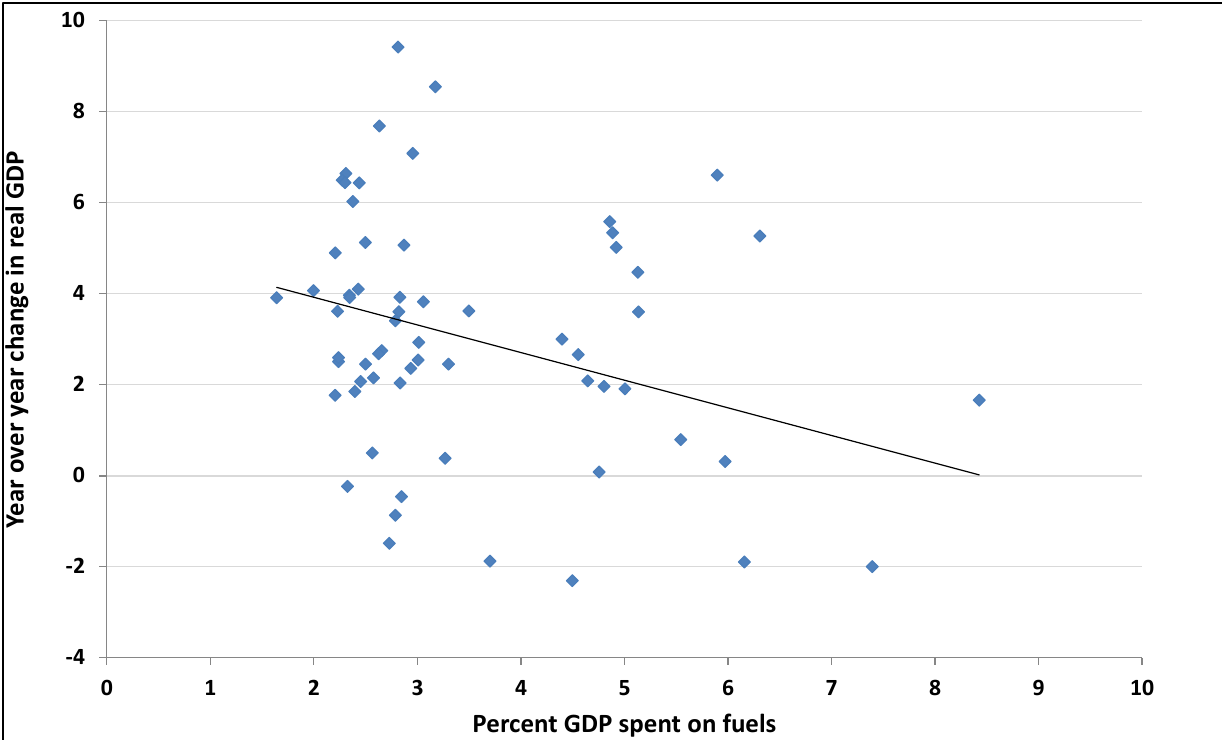
Figure 3. Percent GDP spent on fuels vs. year-over-year GDP change; and best-fitting linear